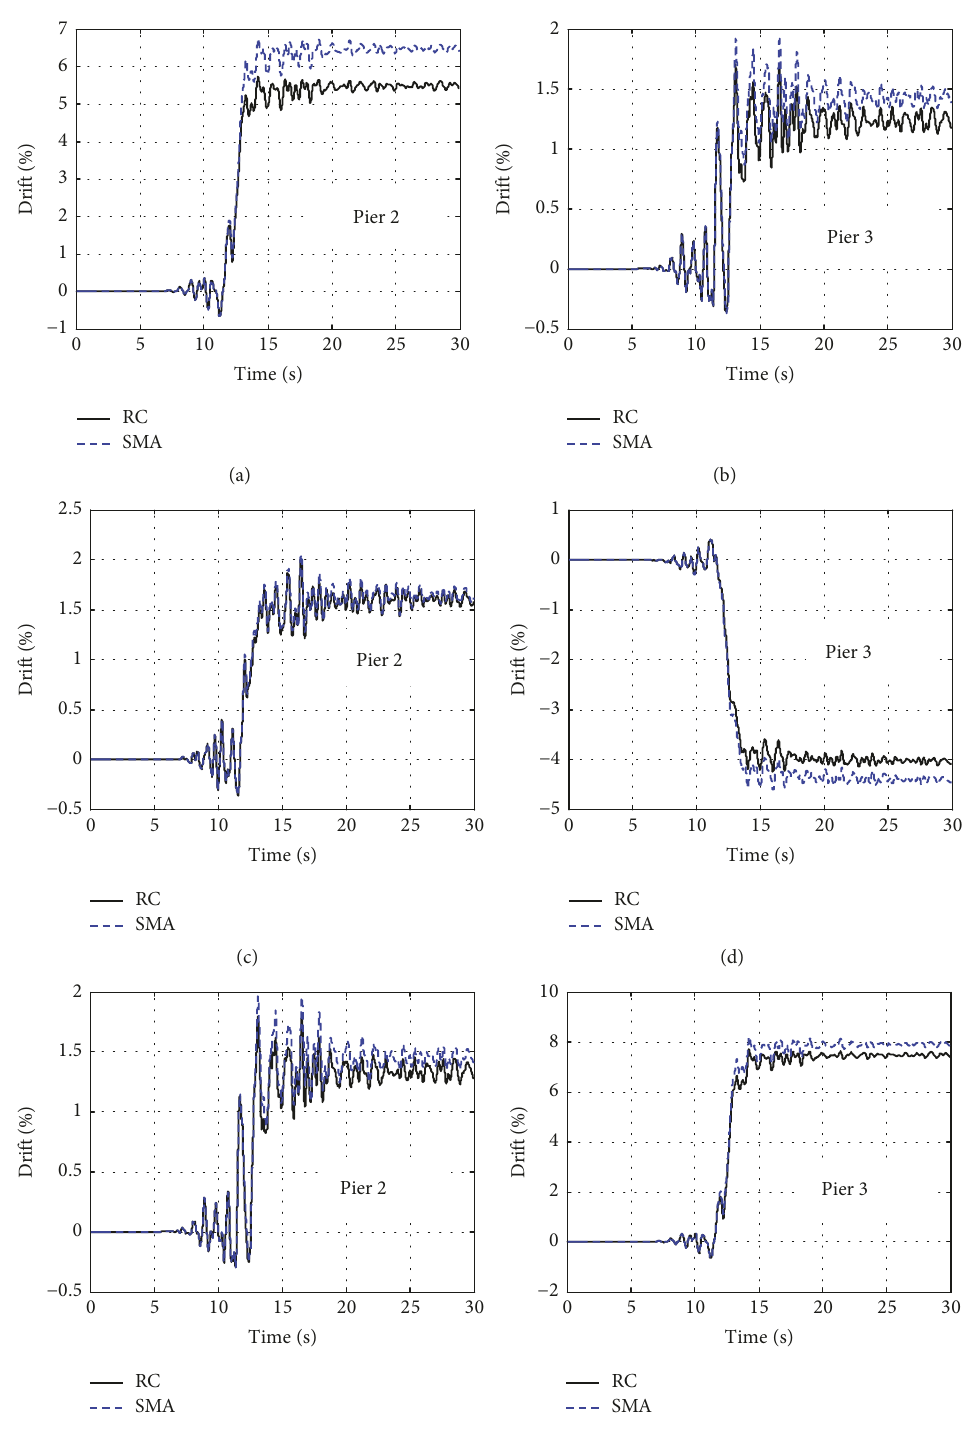
Figure 14: Displacement history of the top column with double amplified motions: (a) Pier 2 in Case 1, (b) Pier 3 in Case 1, (c) Pier 2 in Case 2, (d) Pier 3 in Case 2, (e) Pier 2 in Case 3, and (f) Pier 3 in Case